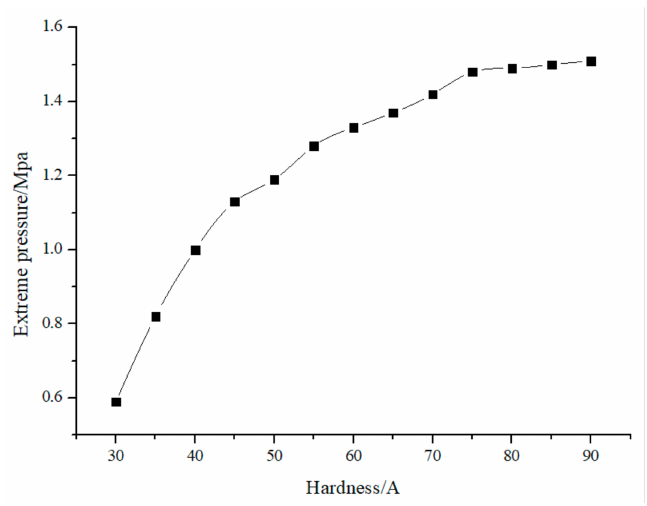
Figure 15. Relationship between RD hardness and limit working